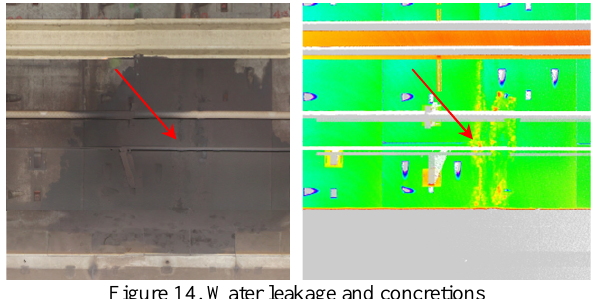
Figure 14. Water leakage and concretions